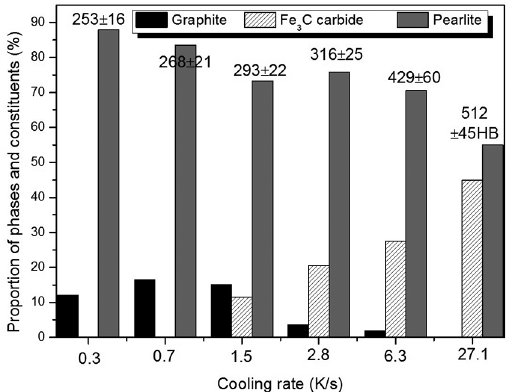
Figure 8: Cooling rate and hardness (HB) experimental relations with the proportions of phases and constituents in the directionally solidified cast iron.